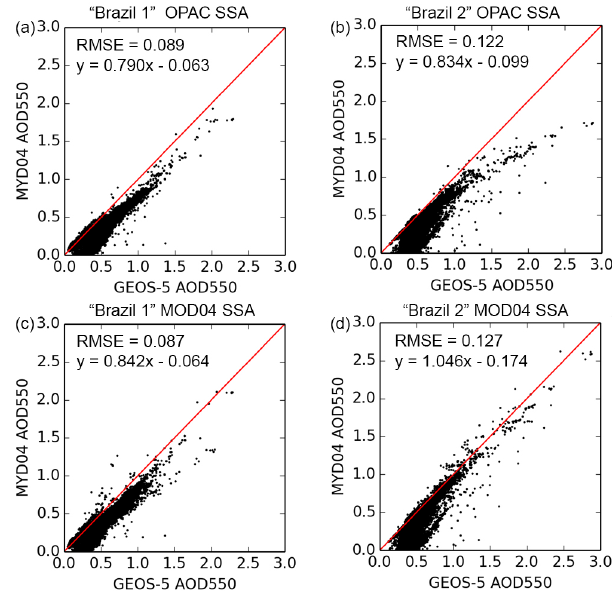
Figure 10. Impact of humidity on MOD04 retrieval illustrated via single scattering albedo selection. Panels (a) and (c) show the Brazil 1 case before and after the SSA adjustment. Panels (b) and (d) show the same for Brazil